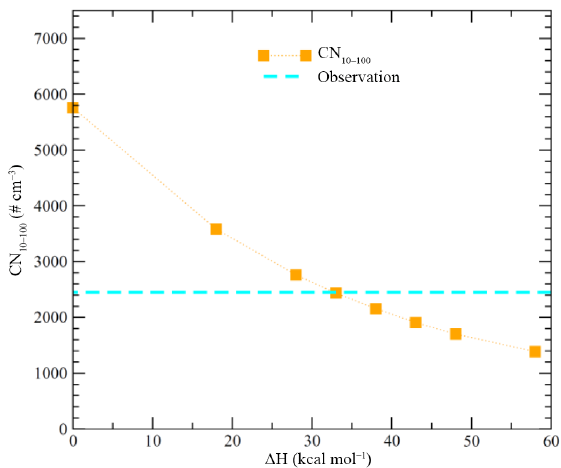
Figure 6. The effect of (cid:49)H values on simulated number concen- trations of condensation nuclei in the size range between 10 and 100nm (CN 10–100 ) in the boundary layer (0–1km) for July 2006 averaged over nine forest sites in North America (NA; locations marked in Fig. 5). The horizontal dashed line shows the average of CN 10–100 observed in a summer month at the nine